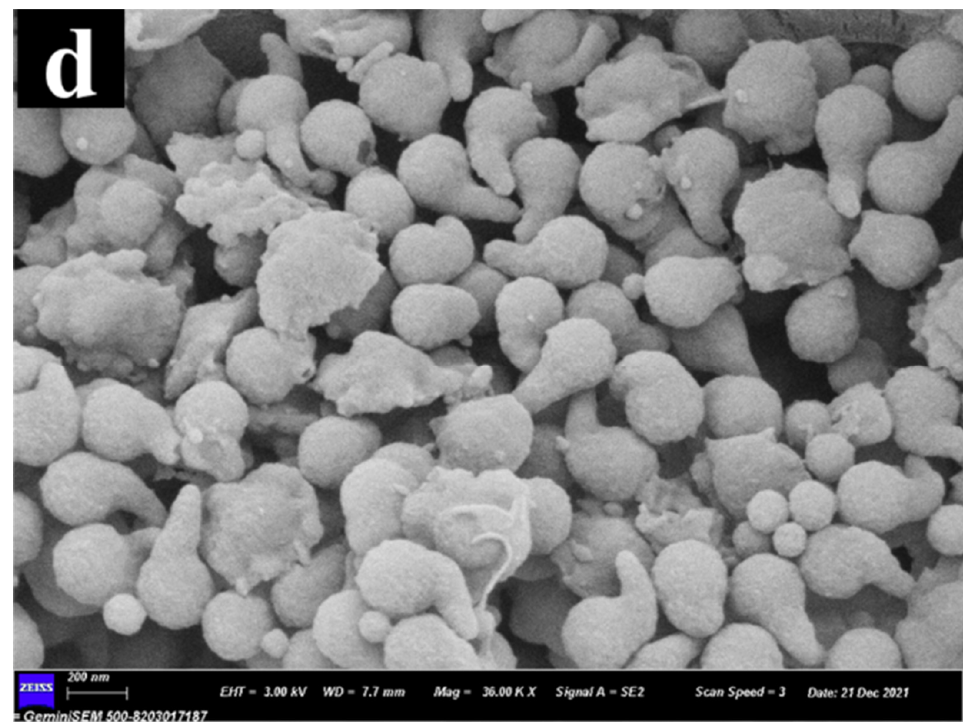
Figure 1. Morphological images of ( a ) 0T-LNP, ( b ) 3T-LNP, ( c ) 6T-LNP, ( d ) 9T-LNP.